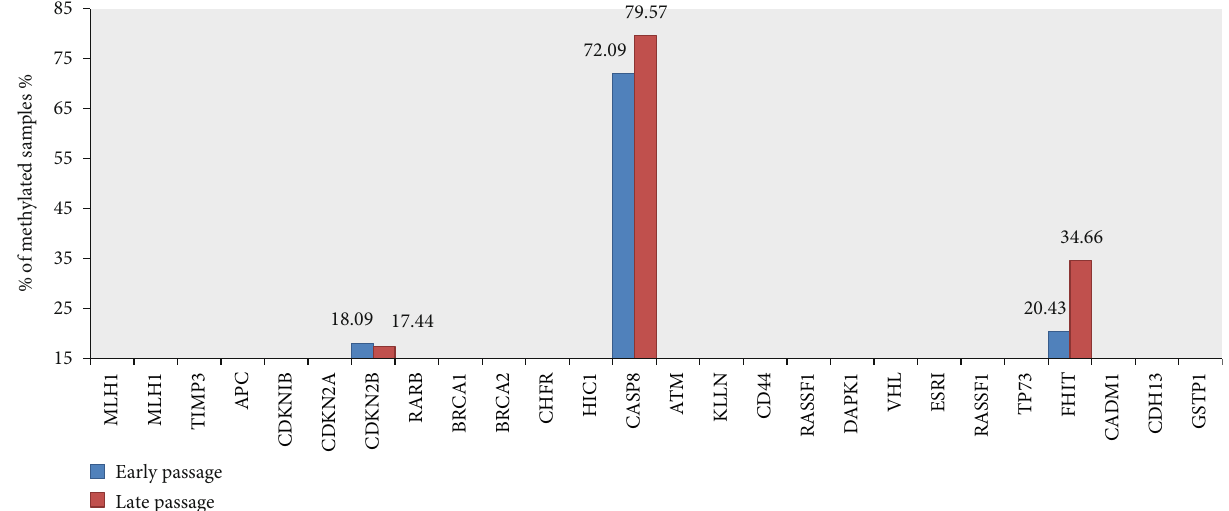
Figure 1: Mean value of methylation frequencies of the 25 analyzed genes in early passage and late passage of 10 cell lines (methylation cut- o ff value